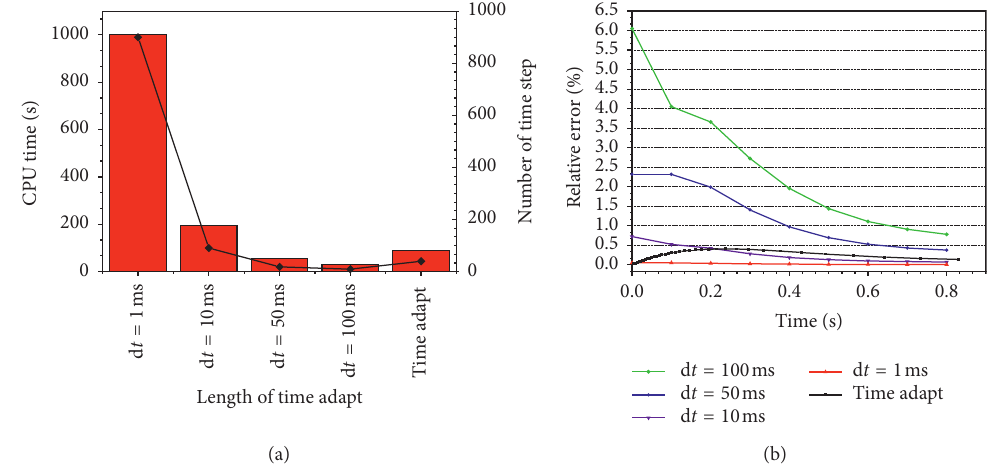
Figure 9: Computational cost and relative power error for the fixed time step method and time adapt